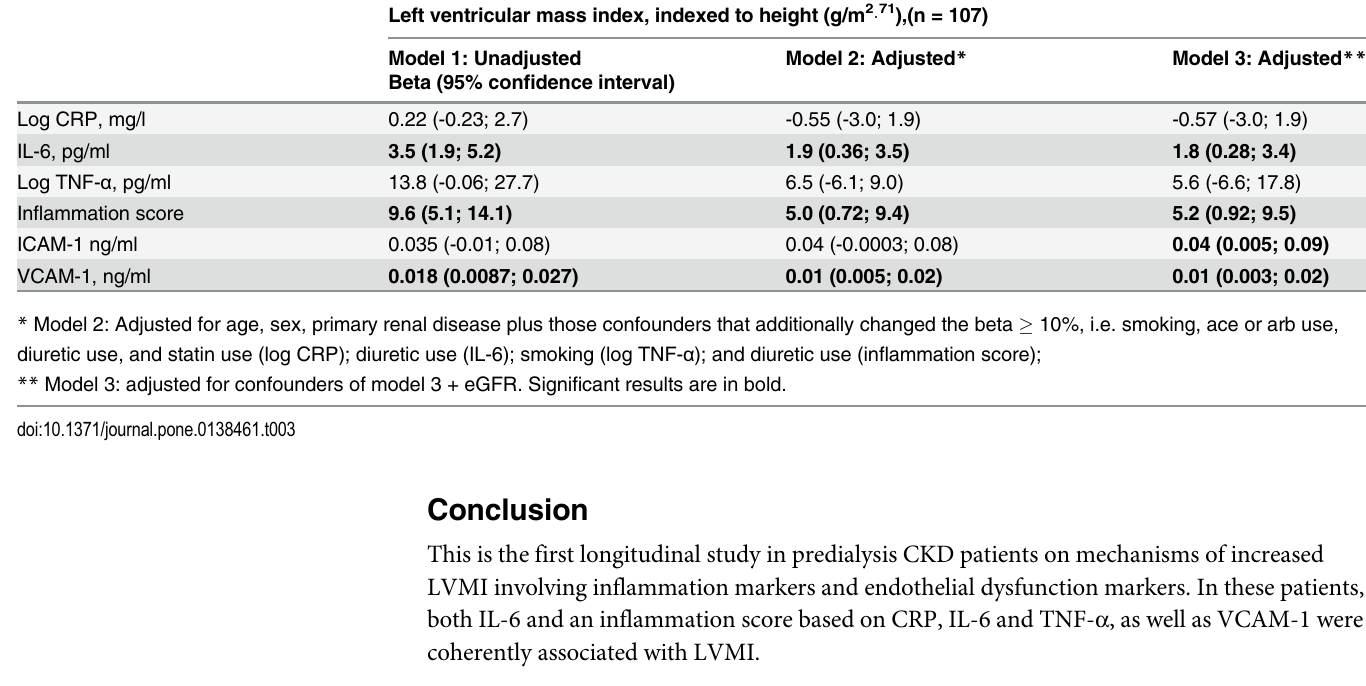
Table 3. The association between inflammation markers and endothelial dysfunction markers and left ventricular mass per year using linear mixed modelling in longitudinal data. Left ventricular mass index, indexed to height (g/m 2 (cid:1) 71 ),(n =